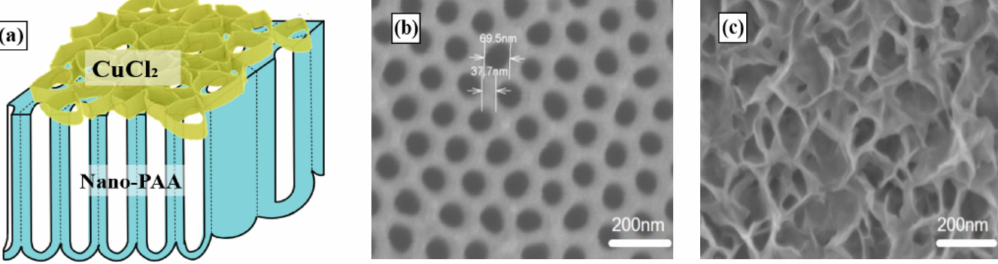
Figure 1. Image of nano-PAA-CuCl2 composite. ( a ) Diagrammatic sketch, and SEM images of nano-PAA sub- strate ( b ) and CuCl 2 nanoflakes ( c ).